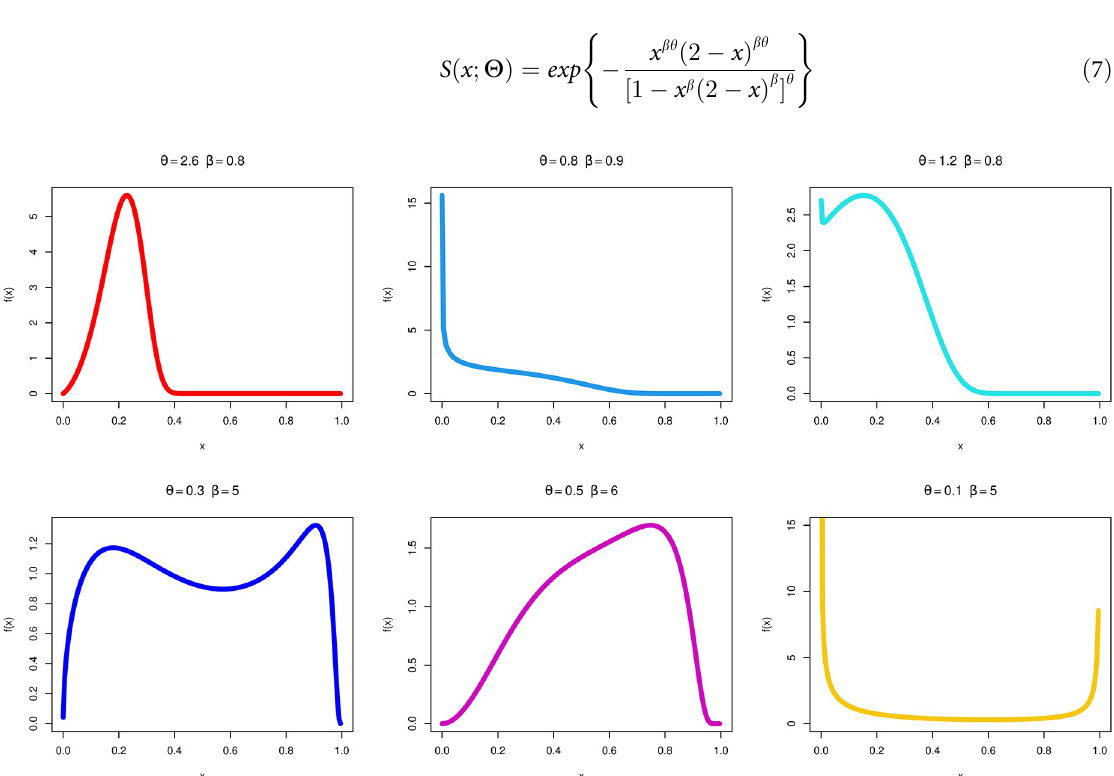
Fig 1. PDF of the MKTL distribution for certain parameter